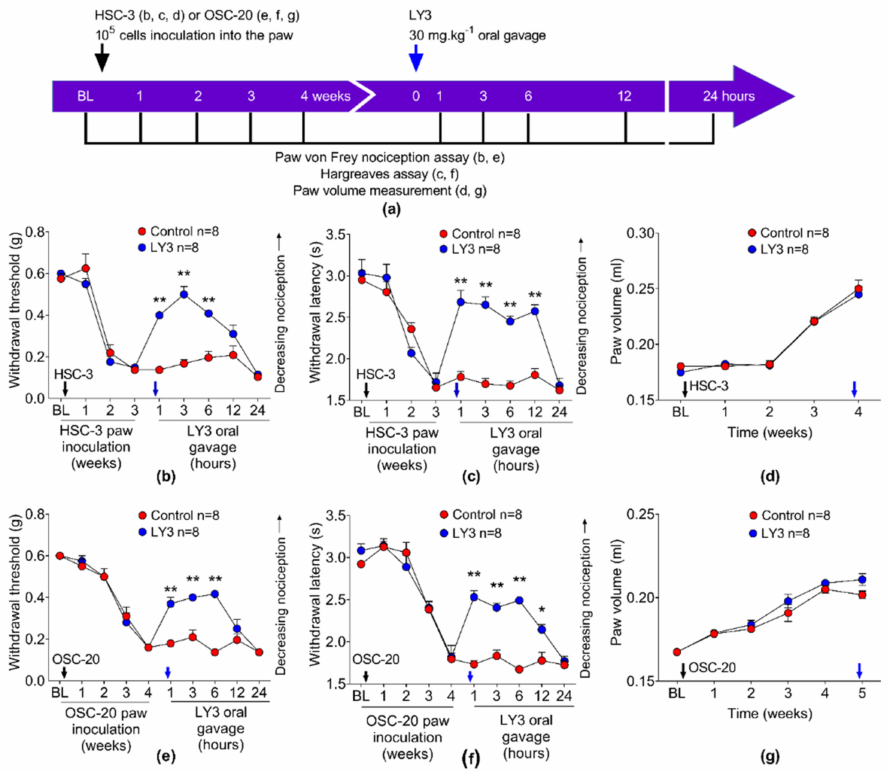
Figure 10. The cathepsin S inhibitor, LY3000328, attenuates nociception in paw xenograft models generated with HSC-3 or OSC-20. ( a ) Experiment timeline for the inoculation of HSC-3 or OSC-20 into the left hind paw of the NU/J Foxn1nu mice, subsequent treatment with the cathepsin S inhibitor, LY3000328, and simultaneous nociceptive behavioral testing. The mice were evaluated with ( b , e ) the paw von Frey nociception assay, ( c , f ) Hargreaves thermal assay, and ( d , g ) cancer paw volume before (BL or Baseline) and at 1, 2, 3, and 4 weeks after inoculation to monitor cancer nociception and cancer paw volume. When the mice developed cancer nociception in two consecutive weeks (i.e., week 2, 3 in HSC-3 paw cancer mice or week 3, 4 in OSC-20 paw cancer mice), the mice were administered LY3000328 (blue arrow). The ( b , e ) paw von Frey nociception assay and the ( c , f ) Hargreaves thermal assay were conducted at 1, 3, 6, 12, and 24 h after LY3000328 treatment. LY3000328 increased ( b , e ) withdrawal threshold and ( c , f ) withdrawal latency relative to LY3000328 vehicle control (i.e., 30% DMSO in normal saline without LY3000328). ( d , g ) LY3000328 did not increase paw cancer volume relative to the control at 24 h after oral gavage of LY3000328. * p < 0.05; ** p < 0.01 LY3000328 versus control, two-way